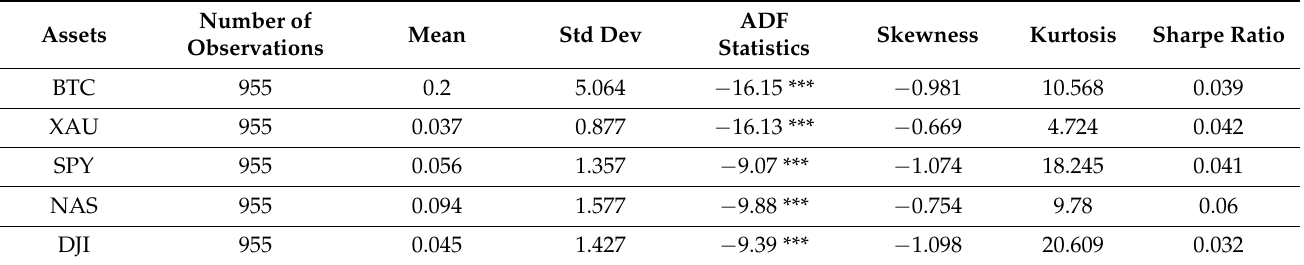
Table 2. Descriptive Statistics and stationarity test for gold, Bitcoin, and 3 US stock indices. *** represents 99% confidence level.